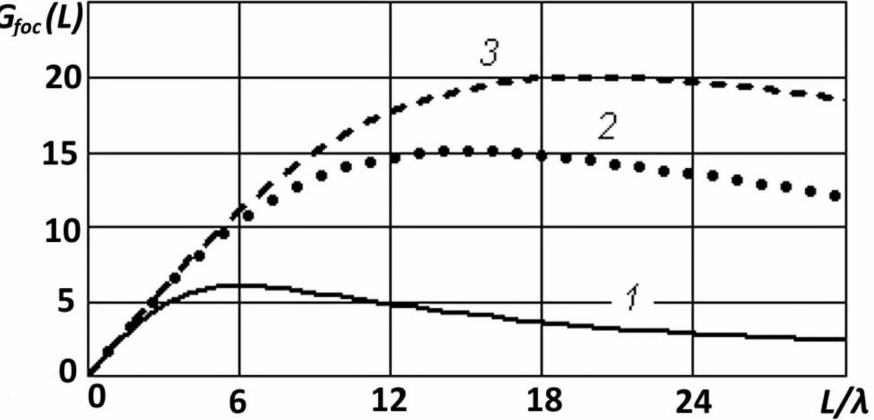
Figure 7. Dependence of G foc on the dimensions of the linear aperture at different depths of focusing point z 0 : curve 1, z 0 = 3 λ ; curve 2, z 0 = 7.5 λ ; curve 3, z 0 = 10 λ .